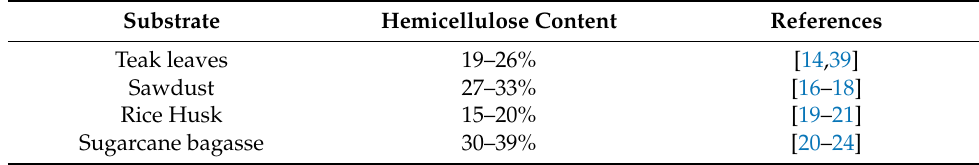
Table 2. Hemicellulose content of different